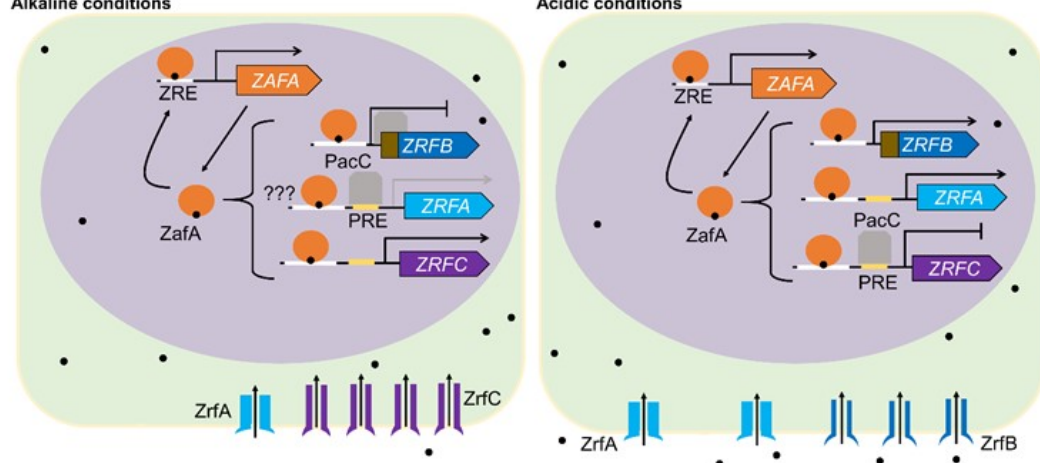
Figure 2. Zinc- and pH-dependent zinc homeostasis mechanisms in Aspergillus fumigatus . Zinc is represented by black dots. Proteins and genes involved in zinc transport are represented by shades of blue, with ZrfC in purple. In conditions of zinc deprivation at acid pH, ZafA (orange circle) induces zrfA and zrfB as well as its own expression by binding to the ZREs (white line) in the promoter region of the target genes. ZafA also binds to zrfC’s ZRE. However, PacC (grey rectangle) is believed to interact negatively with ZafA, since both PacC binding site (PRE, yellow line) and ZRE are in proximity, thereby repressing zrfC transcription. In conditions of zinc deprivation at alkaline pH, ZafA induces zrfC expression and PacC represses zrfB by binding to a PRE region near the TATA box of the gene (brown box). PacC also reduces zrfA expression by unknown mechanisms.